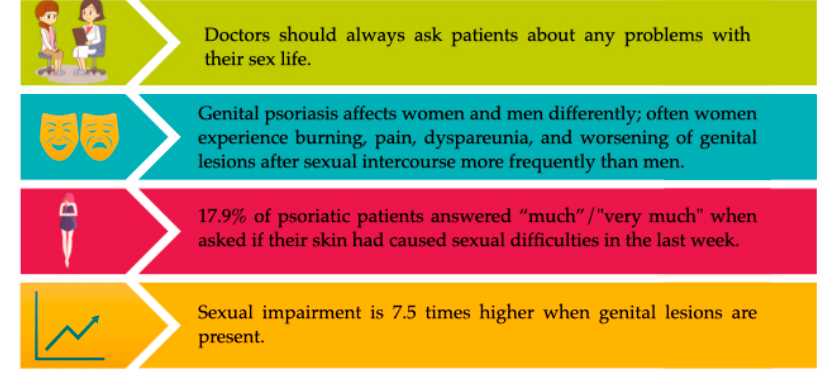
Figure 2. The impact of psoriasis on sex life.